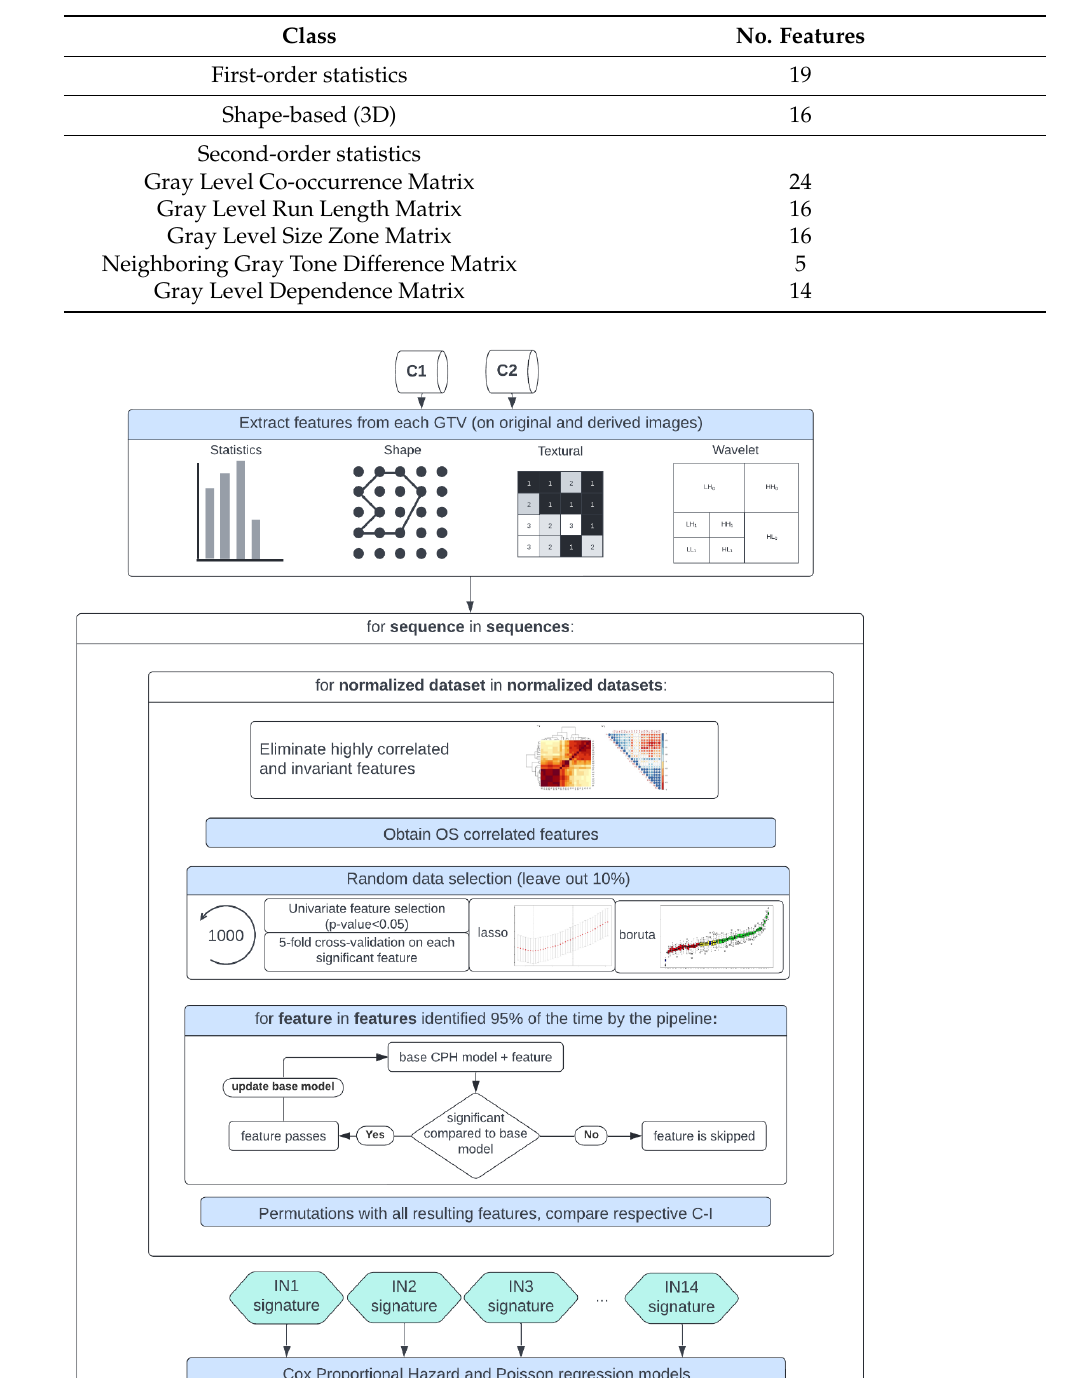
Table 2. The number of shape, first and second-order statistics derived per sequence and calculated on both the original and derived images.